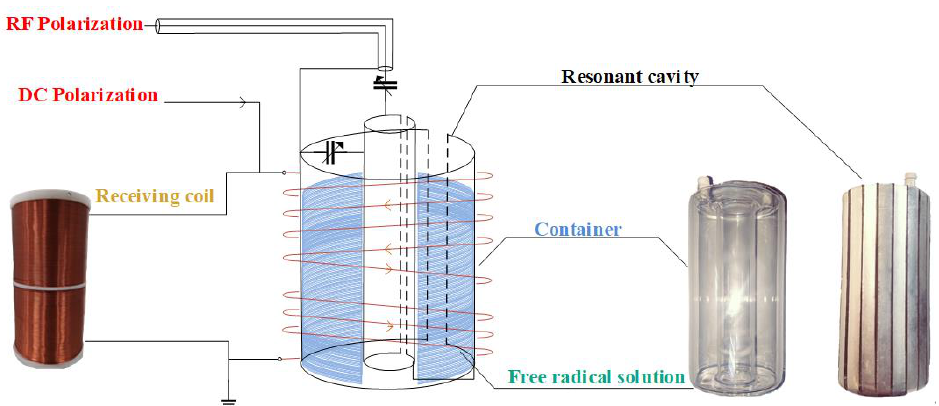
Figure 6. Components of the sensor.